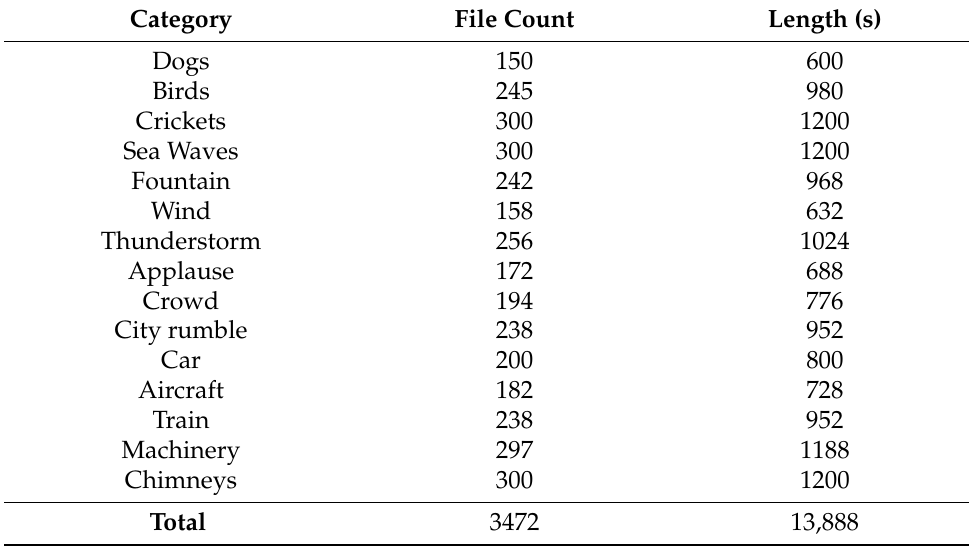
Table 2. Outdoor corpus composition [47].